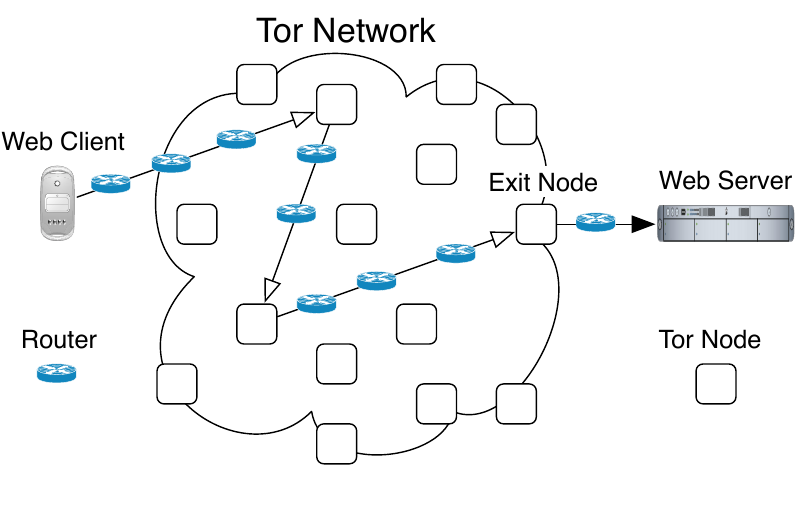
Figure 2. Direct Web Access without Tor.